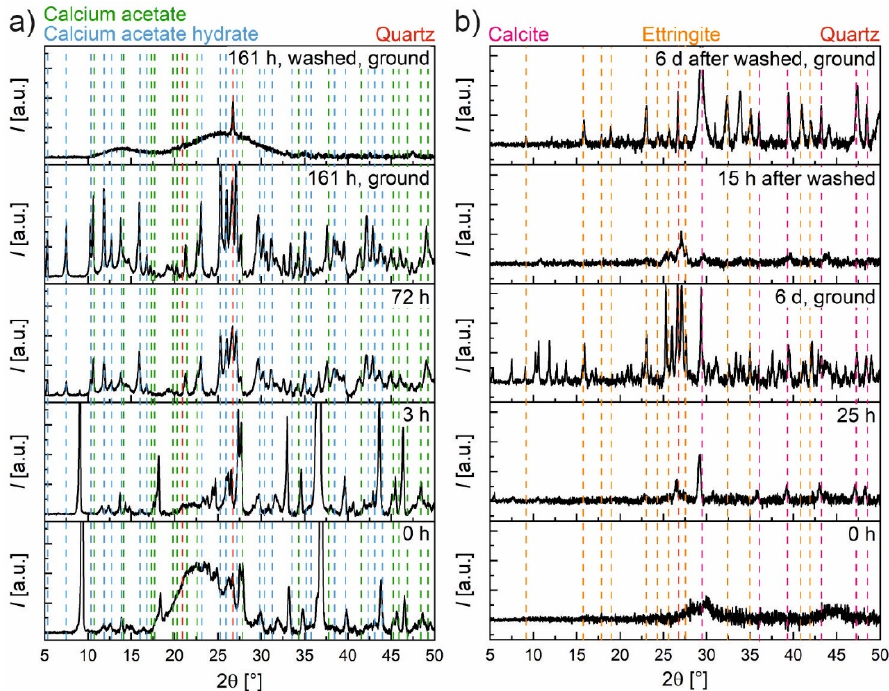
Figure 9. X-ray diffraction patterns of ( a ) one sample of PC after equilibration with diluted acetic acid (350 mmol/g ( hcp ) ) during drying for 161 h and after thoroughly washing with demin. water (phase assignment for 161 h, ground), and of ( b ) one sample of PC + SF after equilibration with diluted acetic acid (11.2 mmol/g ( hcp ) ) during drying for 6 d and of a parallel sample after thoroughly washing with demin. water (phase assignment for 6 d after washed, ground). Note that the diffractograms of the samples that were not ground may be slightly shifted in 2 θ due to the improvised preparation in the sample holder.